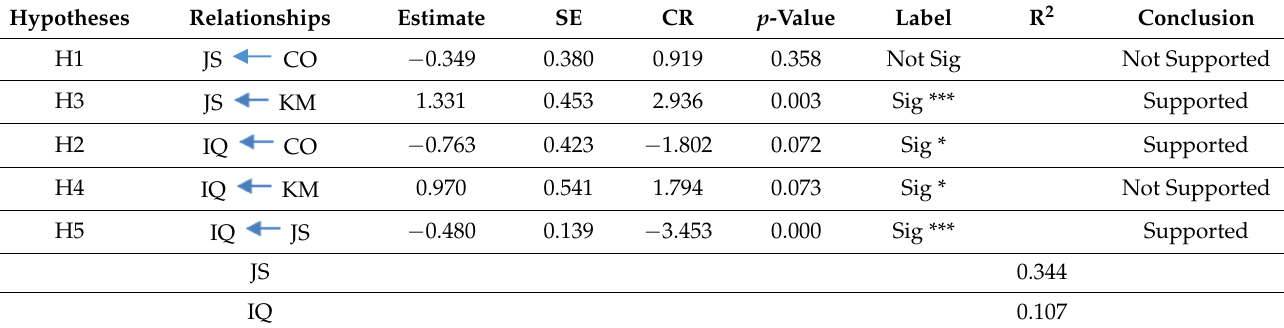
Table 6. Results mediating the hypotheses.